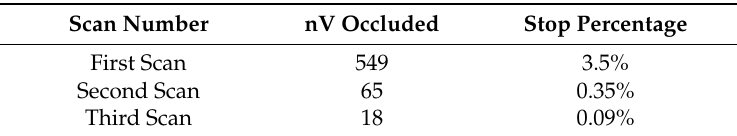
Table 3. Number of occluded voxels with direct or semi-direct line of sight (LOS) from the NBV and stop percentage